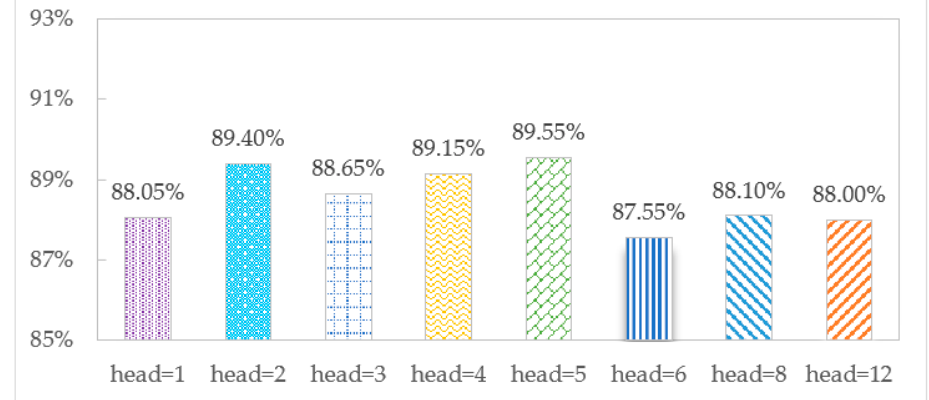
Figure 8. Accuracy comparison for di ff erent numbers of heads on the HTC dataset .